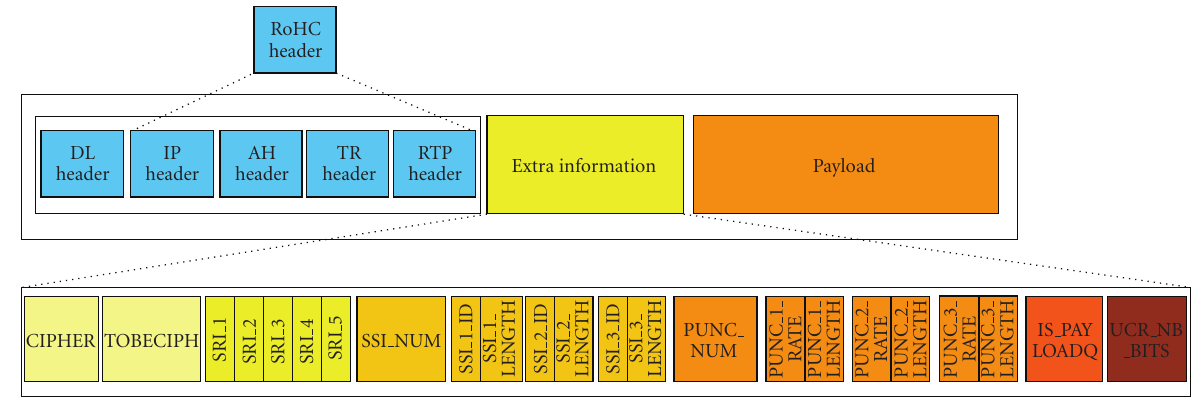
Figure 3: Binary data stream structure and extra information